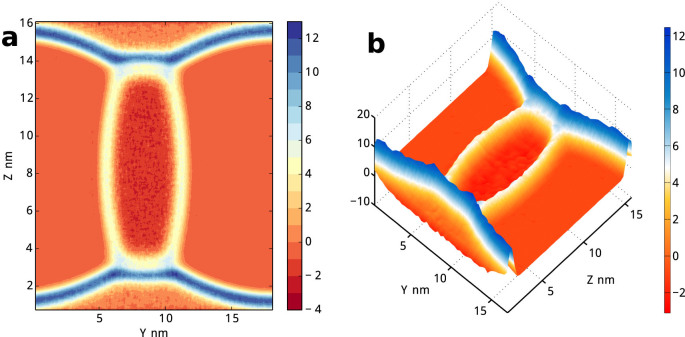
Spatial distribution of −(Pyy(r) + Pzz(r)) in gas/liquid1/liquid2 model.It corresponds to surface tension but containing bulk pressure as background. The unit of stress in the figure is −(pyy + pzz) ≈ 12.1 bar.